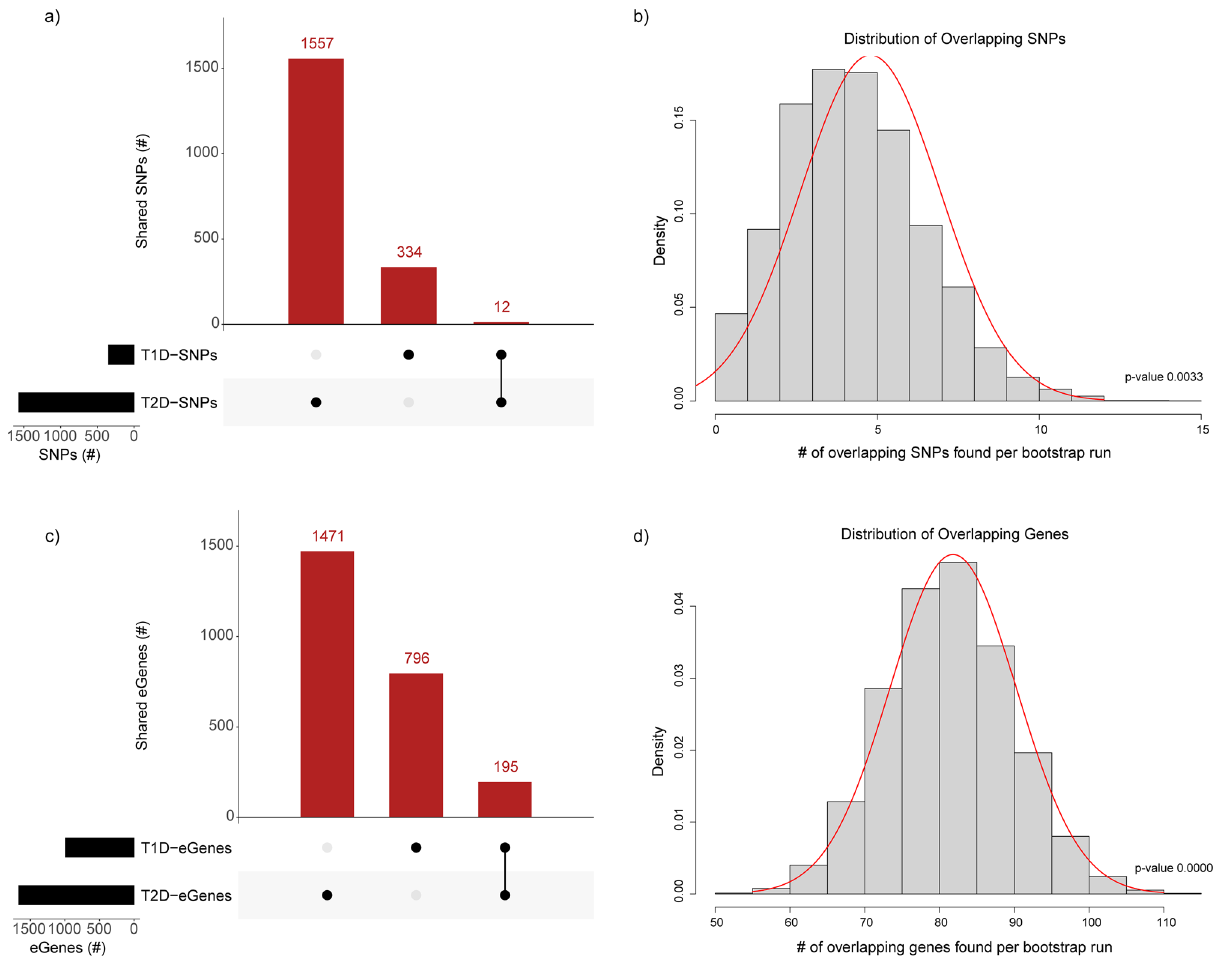
Figure 1. The co-regulation of pleiotropic genes associated with T1D and T2D is non-random. ( a ) A plot showing the number of unique and shared SNPs (imputed and genotyped) associated with the development of T1D and T2D identified from genome-wide association studies. ( b ) A normal distribution plot for randomly sampled SNPs (bootstrapping; n = 10,000) validates the significance of overlaps seen in ( a ). ( c ) The numbers of unique and shared genes modulated by T1D and T2D regulatory SNPs. ( d ) A normal distribution plot for randomly sampled genes (bootstrapping; n = 10,000) validates the significance of overlaps seen in ( c ). eGene—a gene whose transcript levels is associated with an eQTL, eQTL—SNPs associated with transcript levels of genes. Red lines in ( b ) and ( d ) illustrates the fitted normal distribution lines.